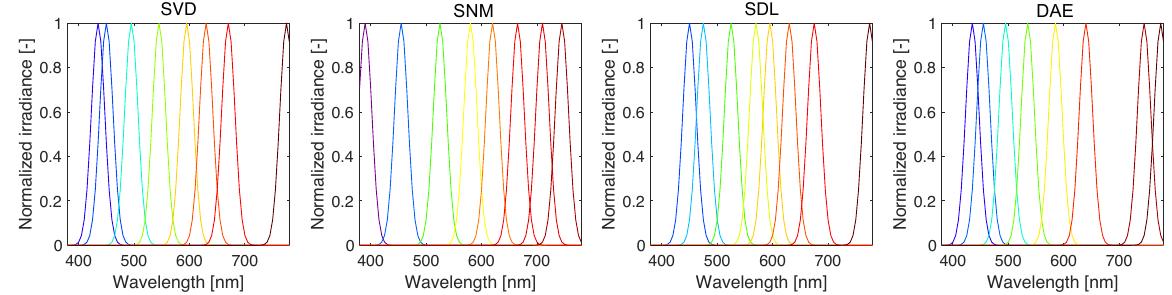
Figure 4. Response functions (shown here for p = 8, σ = 18 nm) constructed via Equation (11). Here, the peak responsivity corresponds to the pivot points derived via QU